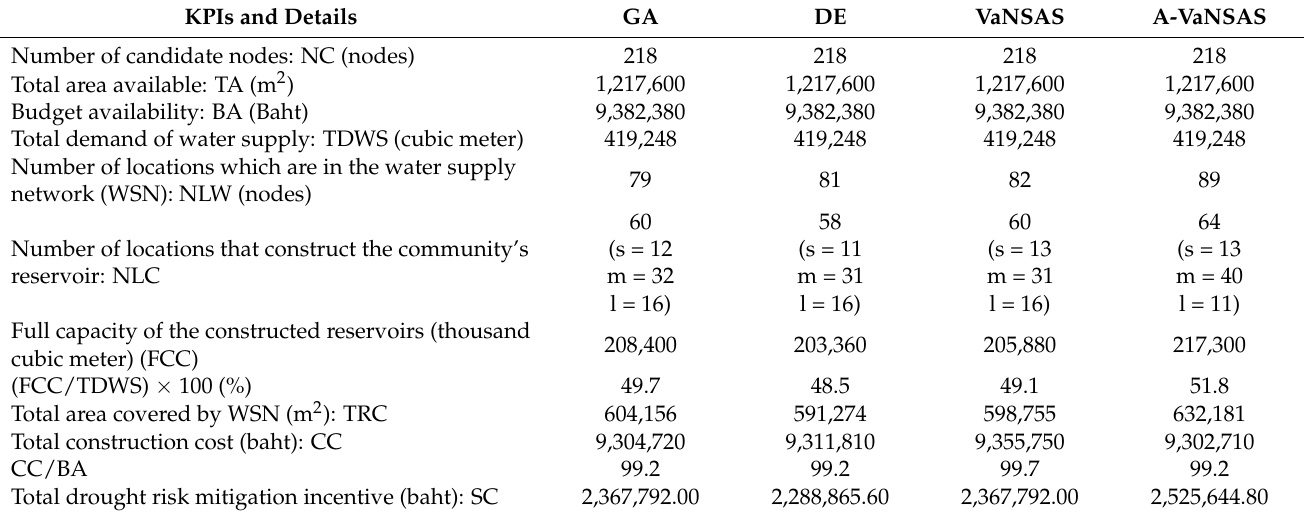
Table 7. Comparison of proposed methods under limited resources with respect to all of the KPIs.